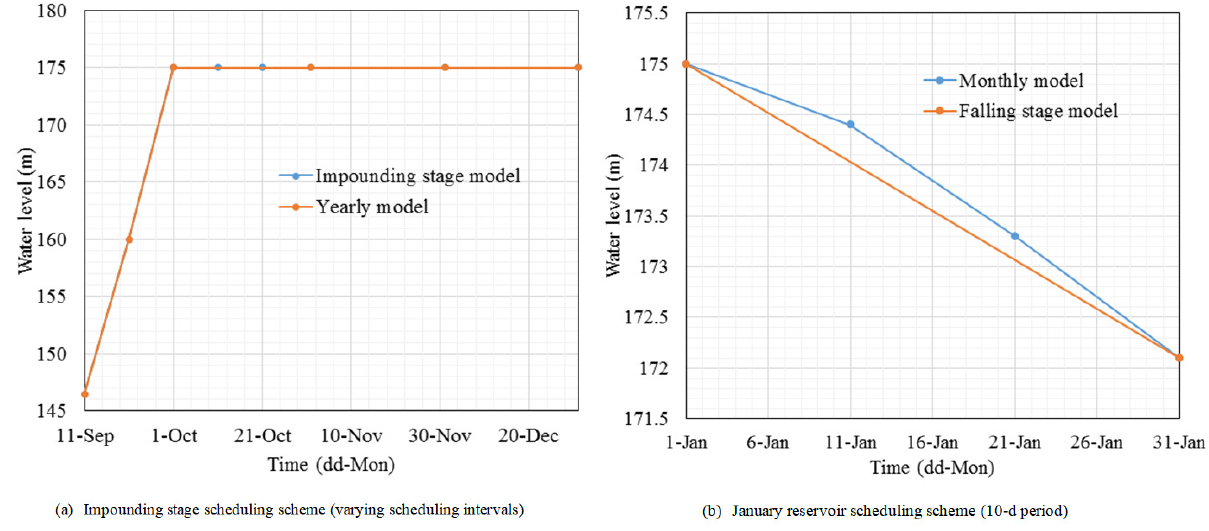
Figure 11. TG reservoir operation plans. Table 6. Implementation effect statistics of flood season scheduling scheme for TG